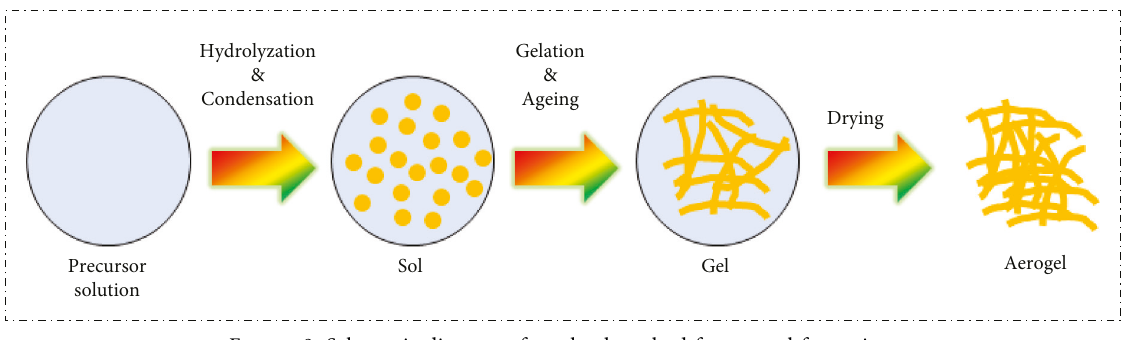
Figure 9: Schematic diagram of a sol-gel method for aerogel